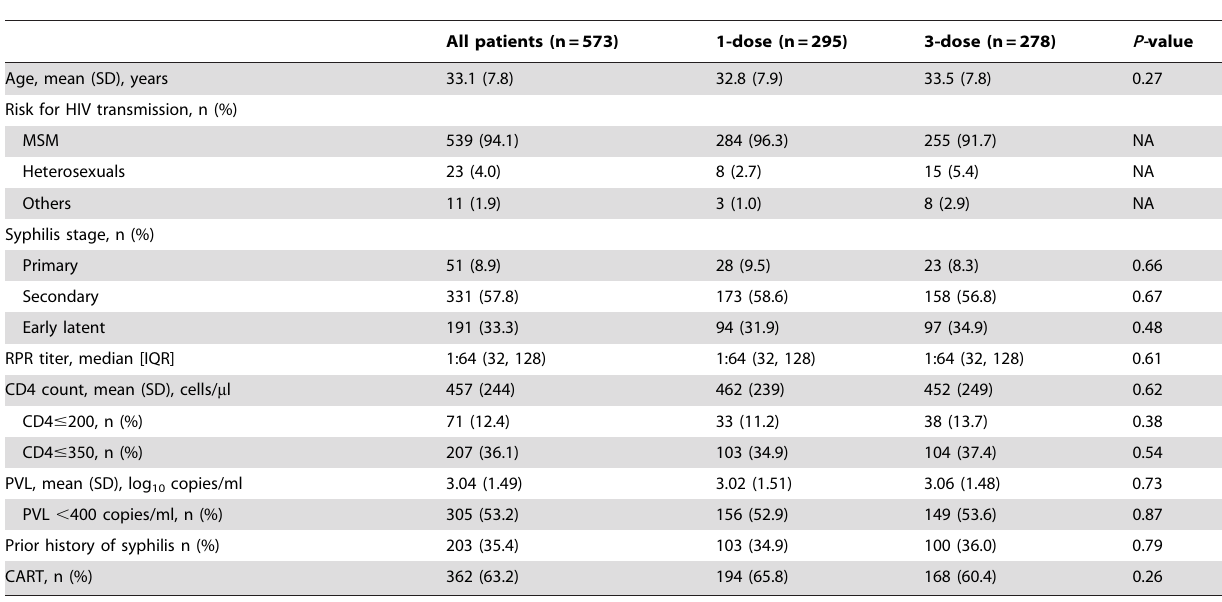
Table 1. Clinical characteristics of HIV-infected patients with early syphilis receiving 1 dose or 3 weekly doses of benzathine penicillin